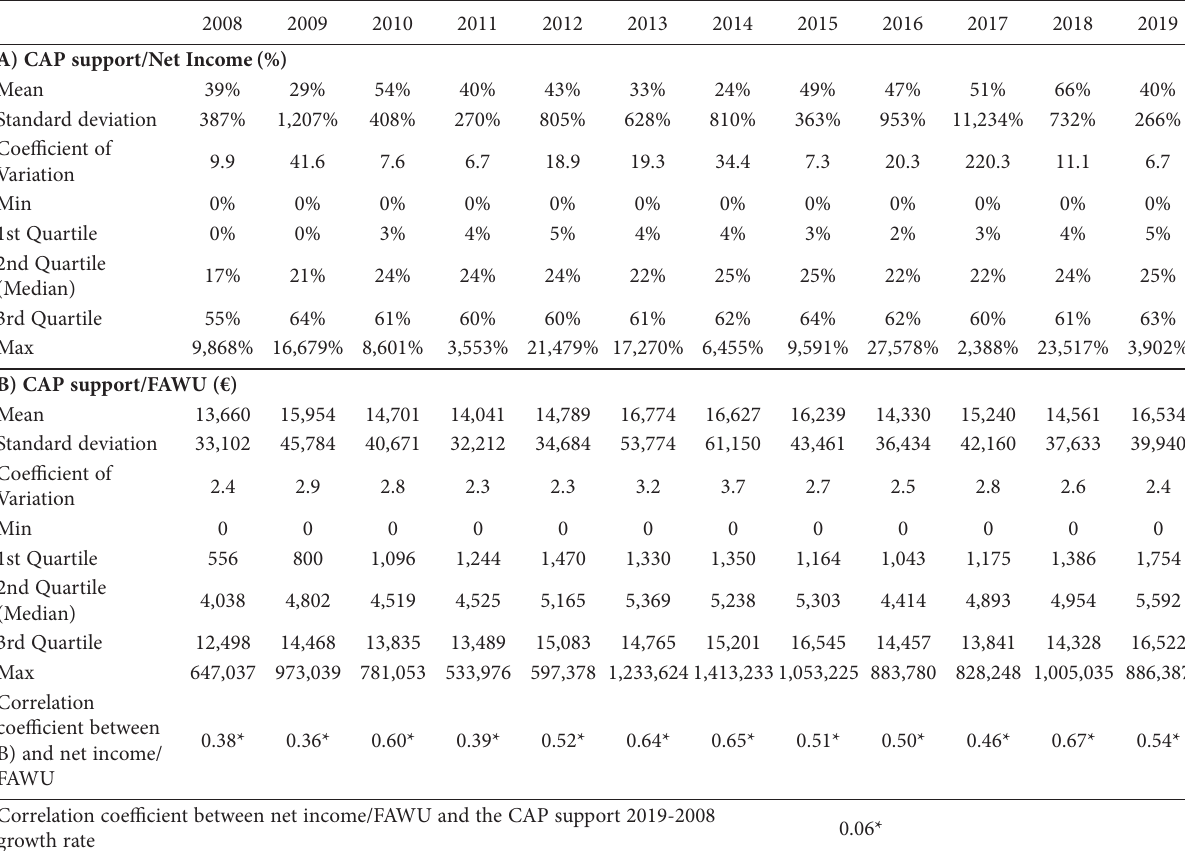
Table 3. Evolution of the CAP support per unit of net income and of AWU within the Italian 2008-2019 FADN balanced